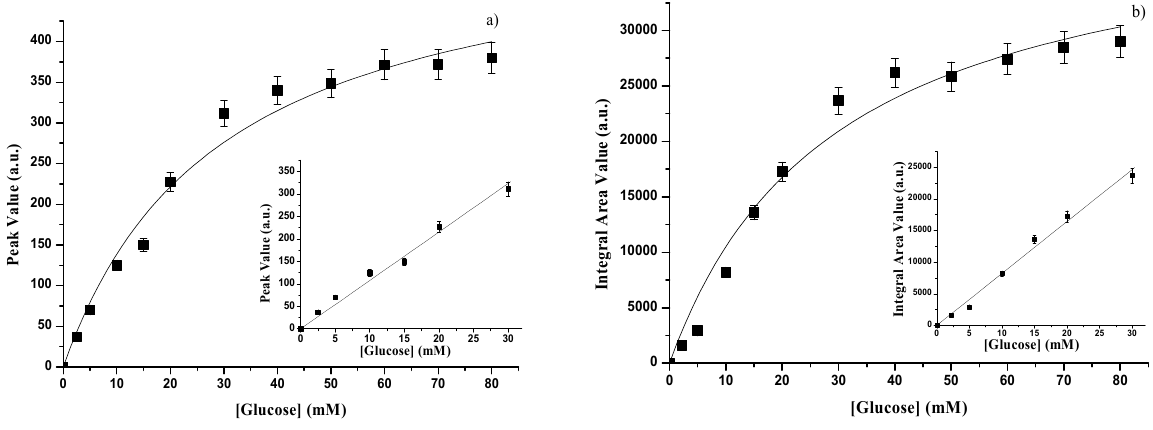
Figure 4. Immobilized GOD - (a) Fluorescence emission peak as a function of glucose concentration. Inset: glucose calibration curve. (b) Fluorescence emission integral area as a function of glucose concentration. Inset: glucose calibration